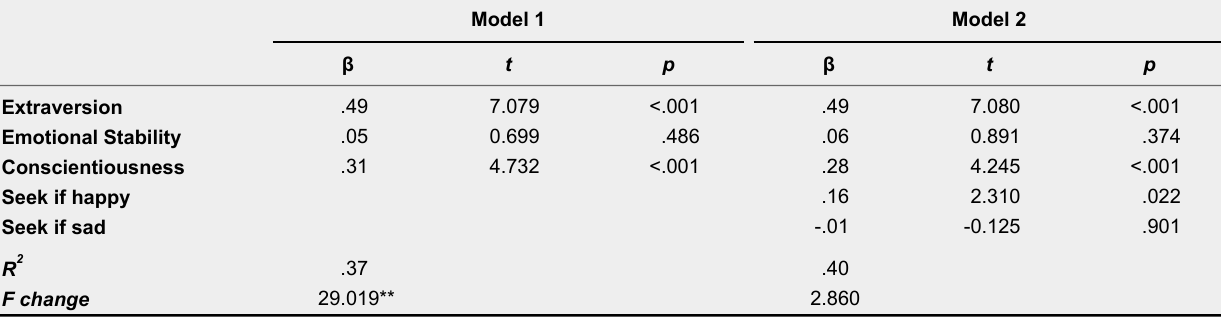
Hierarchical Multiple Regression of Positive Mood (PA) Onto Personality and the Use of Nature for Emotion Regulation (Males, N =